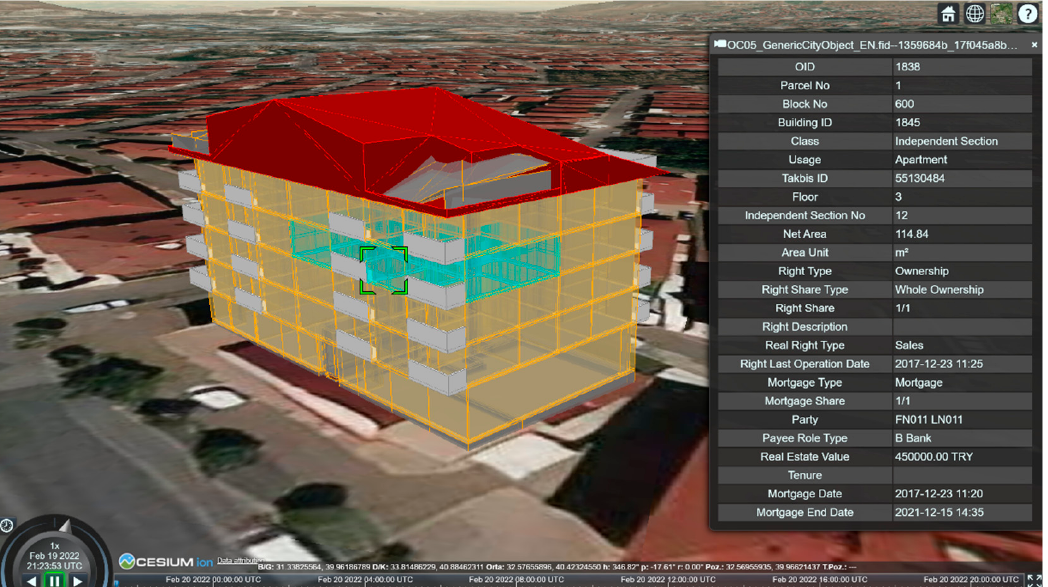
Figure 6. The 3D visualization of the created 3D Building is based on the Turkish cadastral system’s ADE 4D Cadastral Data Model, and its time and cadastral information results.